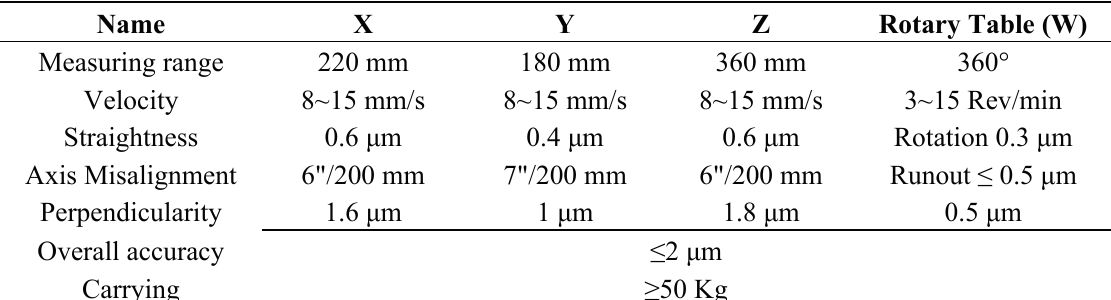
Figure 2. The blade measuring instrument and the fixture. Table 2. Coordinate axis parameter